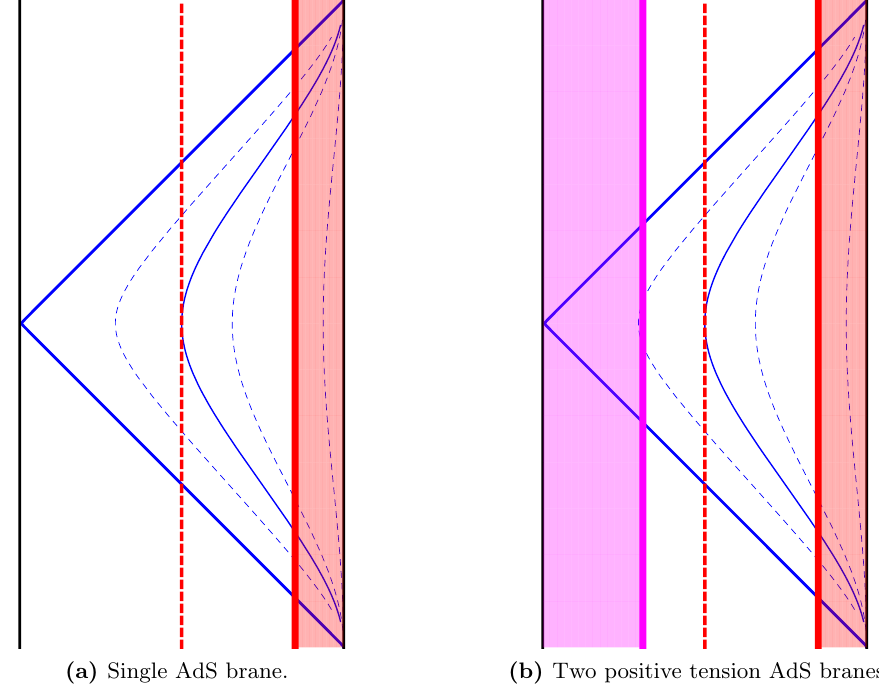
Figure 3. Vertical cross sections of Anti-de Sitter branes.